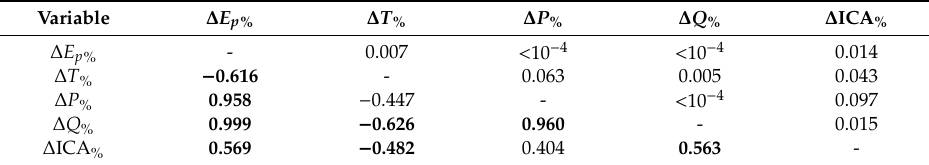
Table 6. Correlation analysis of changes in energy production Ep against climatic and hydrologic drivers, yearly scale. Below diagonal, Pearson correlation coe ffi cients. Significant ( α = 5%) correlation coe ffi cients are in bold. p -values are above the diagonal. Variable ∆ E p % ∆ T % ∆ P % ∆ Q % ∆ ICA % ∆ E < 10 − 4 < 10 − 4 0.014 p % - 0.007 ∆ T − 0.616 - 0.063 0.005 0.043 % ∆ P − 0.447 - < 10 − 4 0.097 % 0.958 ∆ Q − 0.626 0.960 - 0.015 % 0.999 ∆ ICA − 0.482 0.404 0.563 % 0.569